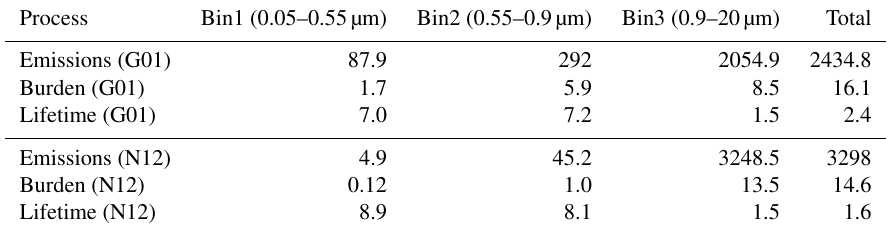
Table 6. Desert dust emissions, burdens and lifetimes simulated by IFS-AER with the Ginoux01 (G01) and Nabat12 (N12) schemes (emis- sions are in Tgyr − 1 , burdens are in Tg and lifetimes are in